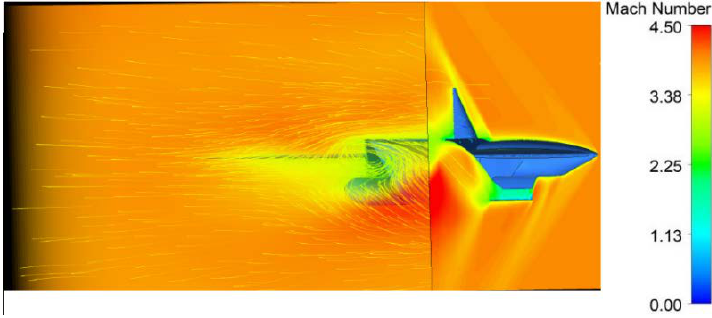
Figure 29. Velocity streamlines and displaying the effect on the SERN performance at Mach 4.5.